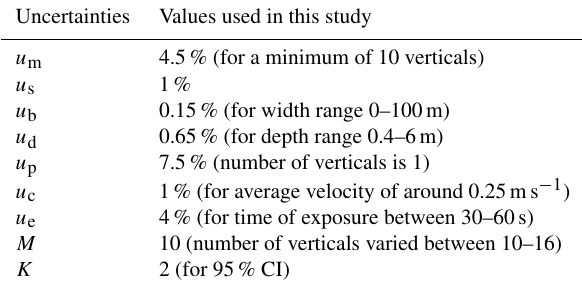
Table A2. Standard uncertainties in a single measurement of stream discharge due to seven measurement errors, using empirical values from WMO (2010). The final uncertainty due to measurement error is calculated with a 95%CI using the empirical values from this table. Please refer to Table A1 for nomenclature. Uncertainties Values used in this